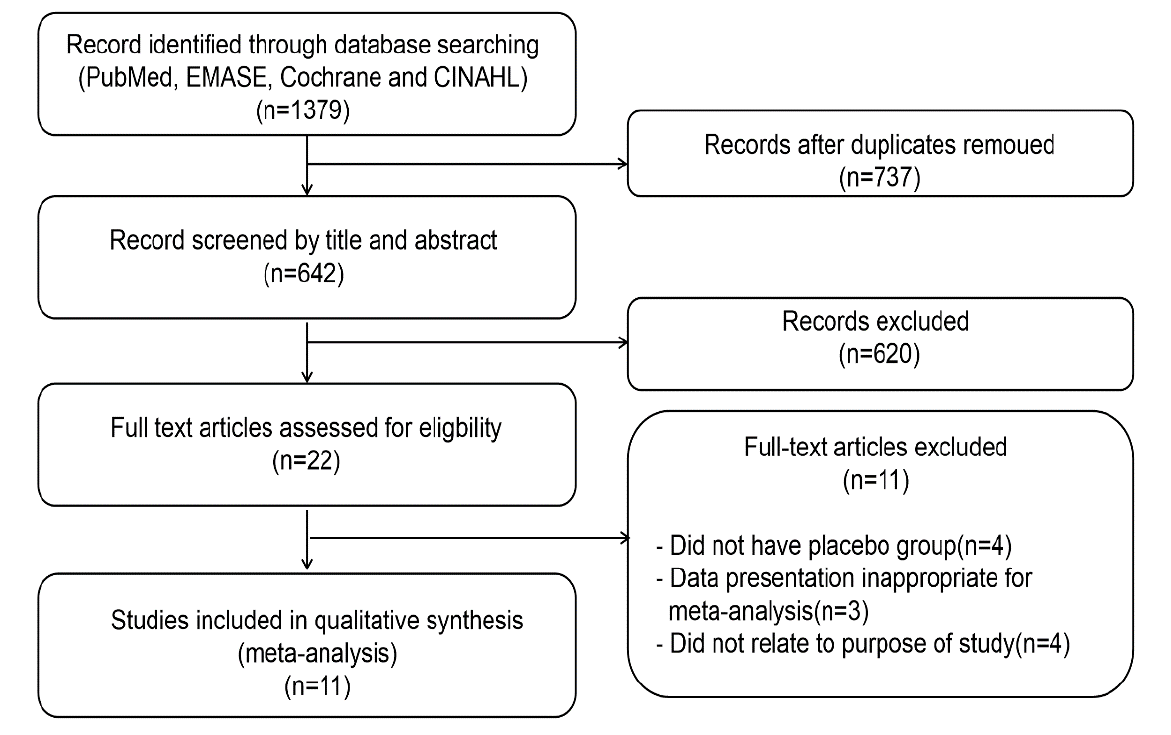
Figure 1. Flow chart of the study selection process for SR-MA.